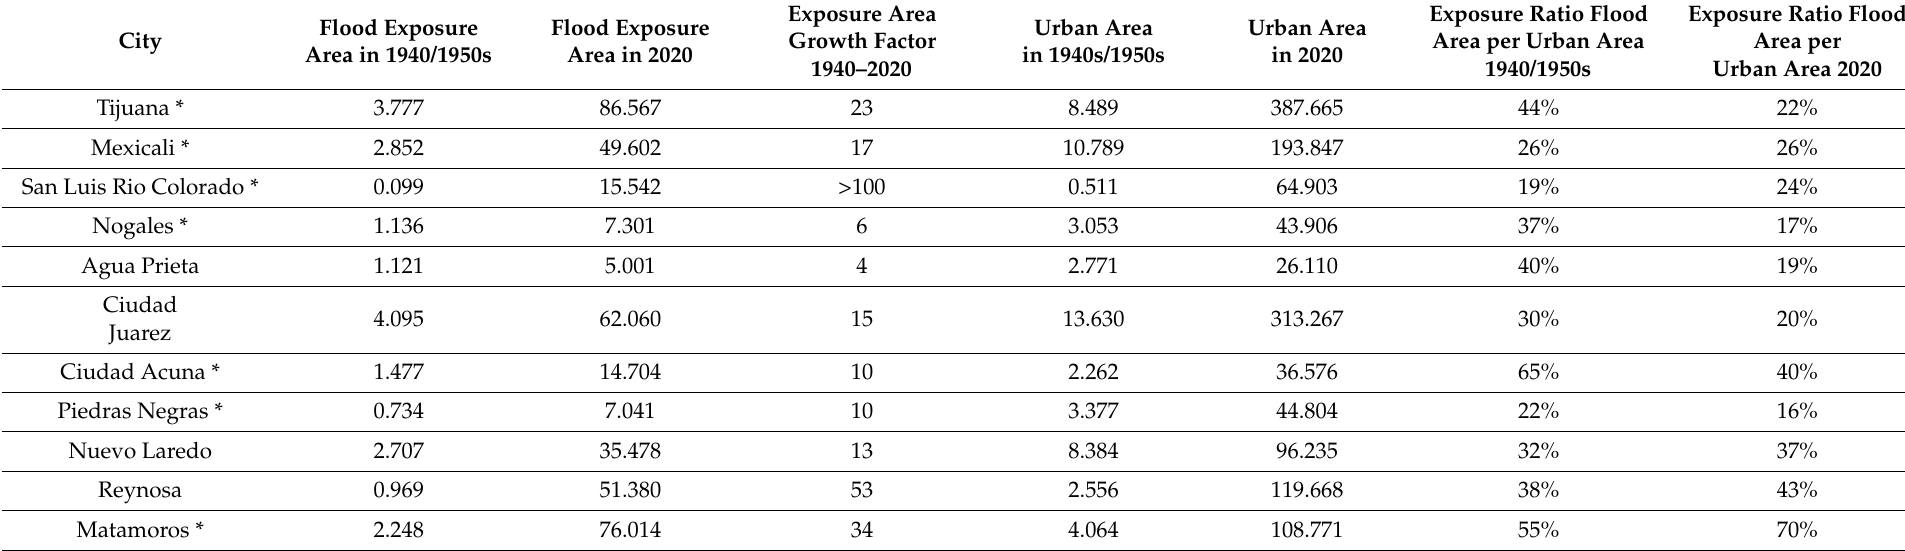
Table 5. Development of hazard exposure as calculated by the flood zones from the Atlas Nacional de Riesgos por Inundaci ó n overlapping with the urban areas mapped on the Mexican